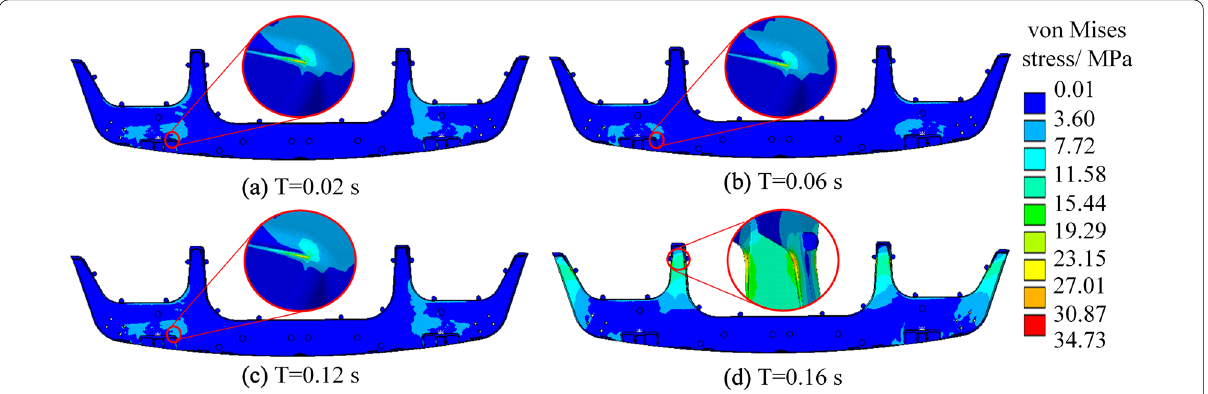
Figure 8 Von-Mises stress contour of the cast aluminum beam under cyclic